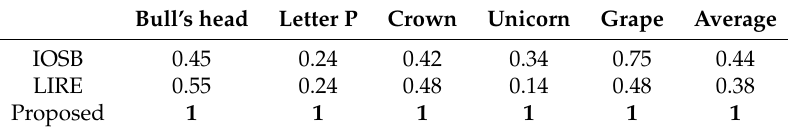
Table 7. mAP scores of the three systems on TestSet50.